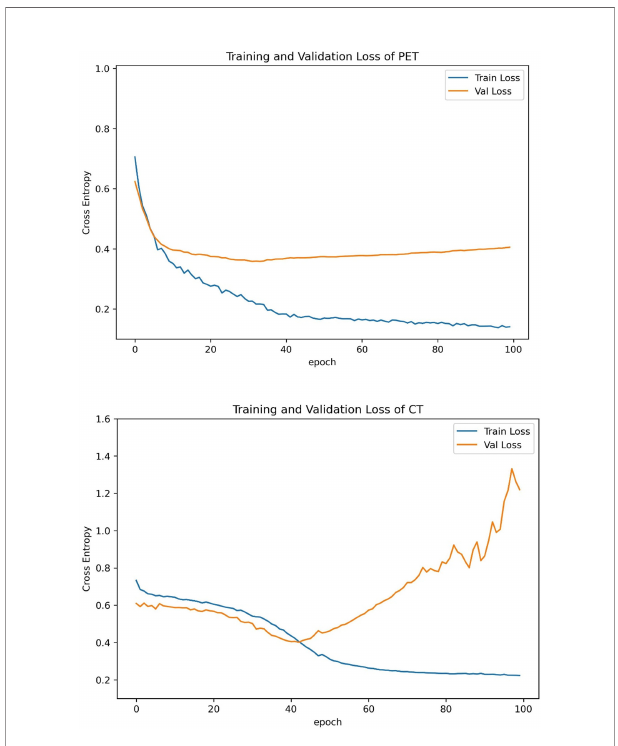
FIGURE 4 | Training curves of PET and CT models. We stopped training at the 40th epoch because no further improvement can be gained in the validation